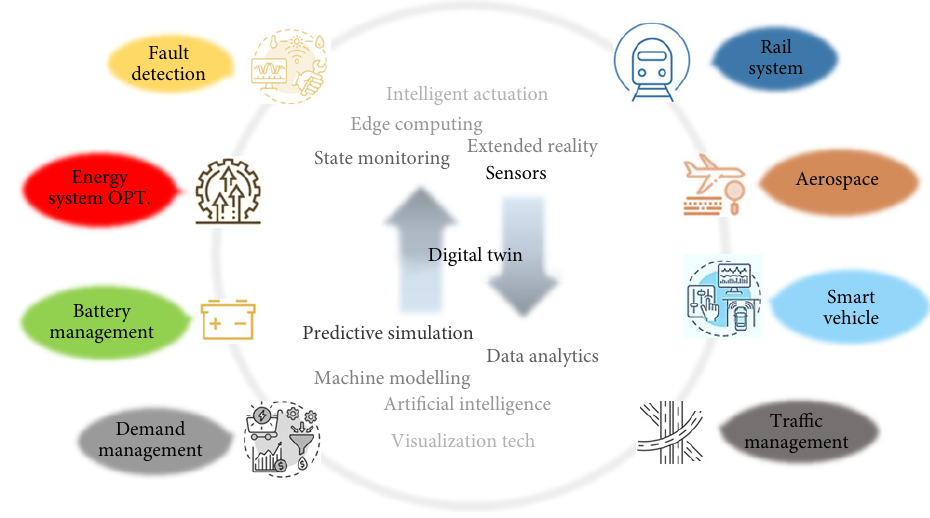
Fig. 2 Supportive technologies and theories of digital twin and its main applications in the field of energy and